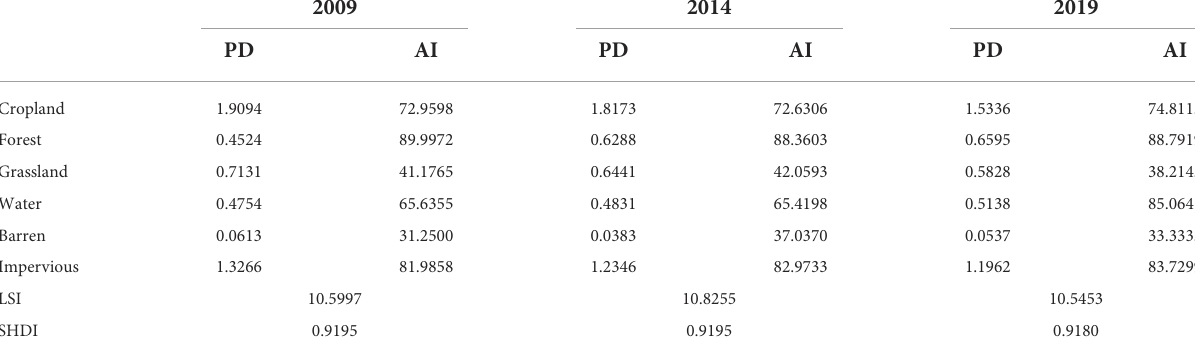
TABLE 5 Landscape index calculation for 2009, 2014, and